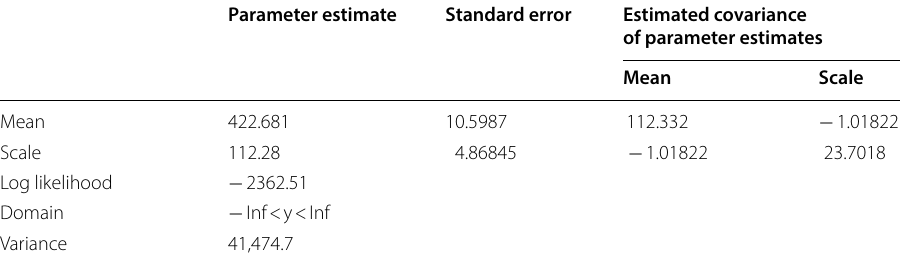
Table 4 Logistic distribution fitting model parameters for the internet upload traffic